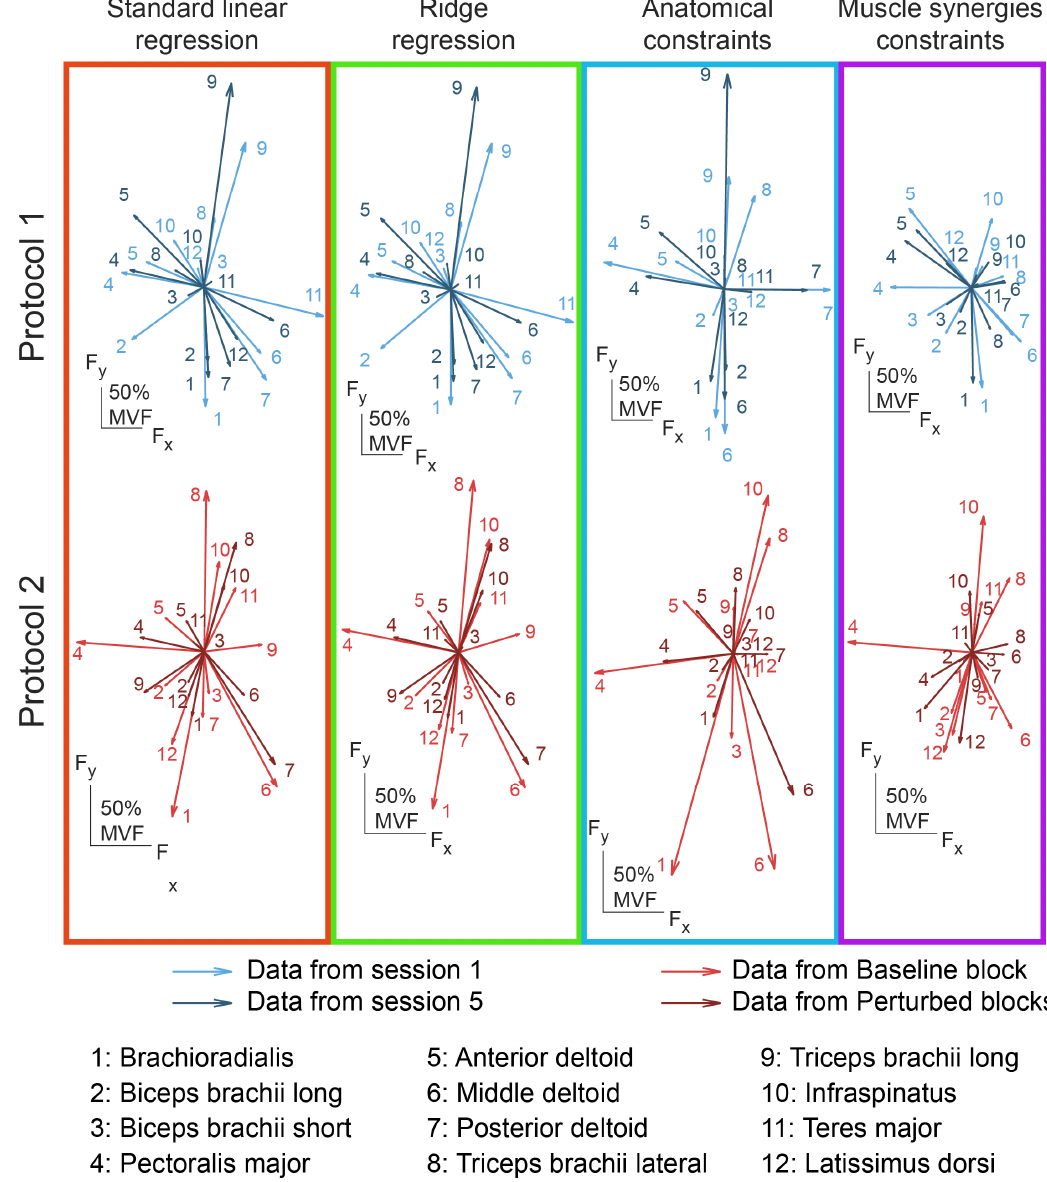
Figure 7. Examples of the pulling vectors of the EMG-to-force mappings calculated with different approaches. In the upper panels are reported the pulling vectors of two EMG-to-force mappings, extracted from data collected during session 1 (light blue) and session 5 (dark blue) of protocol 1, with different approaches. In the lower panels are reported the pulling vectors of two EMG-to-force mappings, extracted from data collected during baseline block (light red) and perturbed blocks (dark red) of protocol 2, with different approaches. Each column represents a different estimation approach, and each number indicates a muscle.